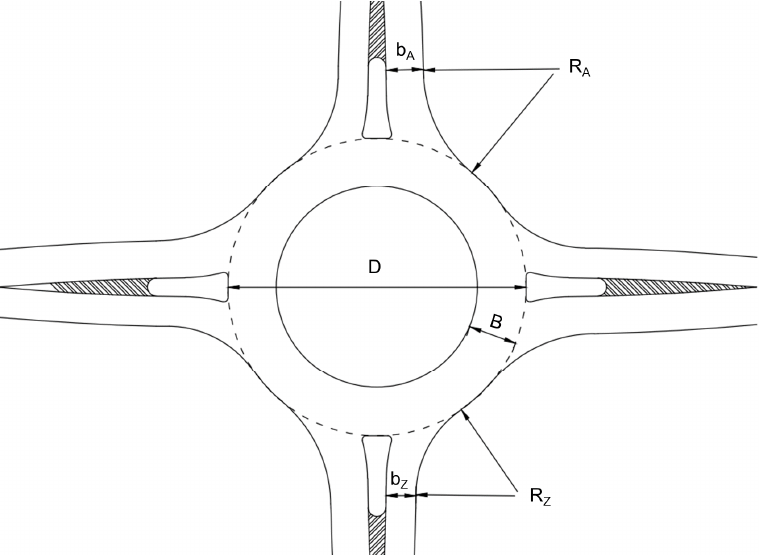
Figure 14. Funnel-shaped splitter islands on suburban roundabouts according to [9].